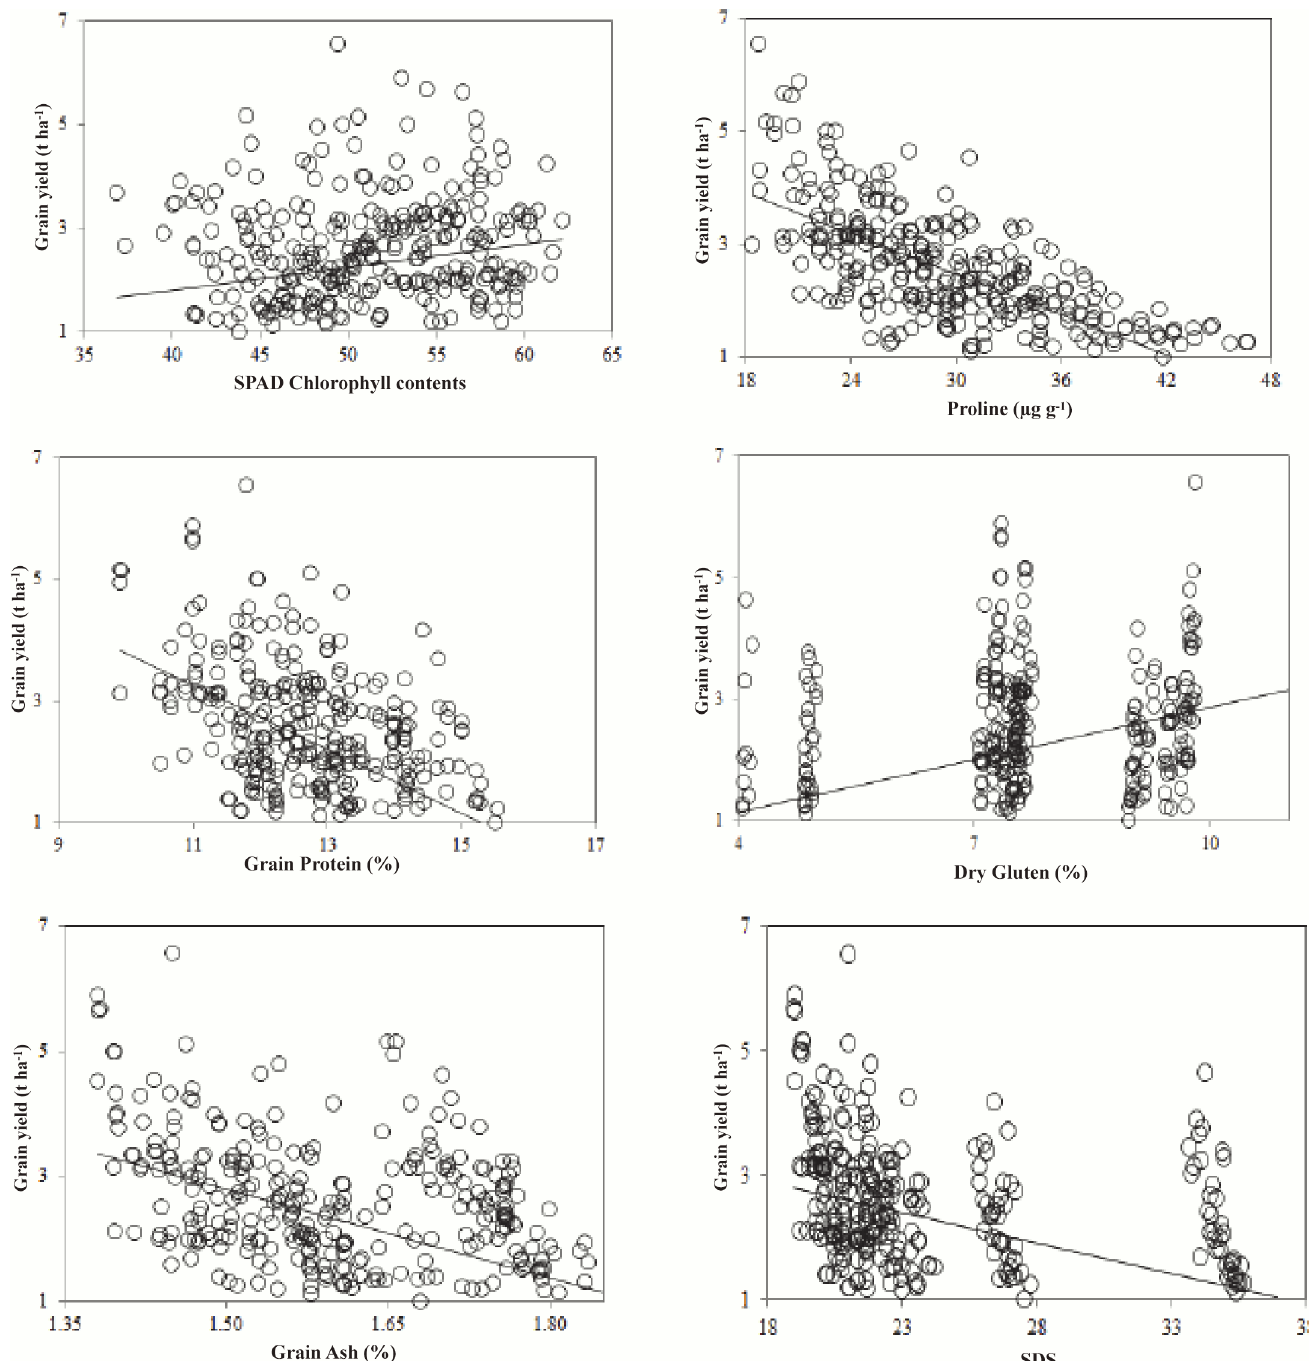
Fig 4. Relationship of physiological, grain quality traits with grain yield of wheat combined over all